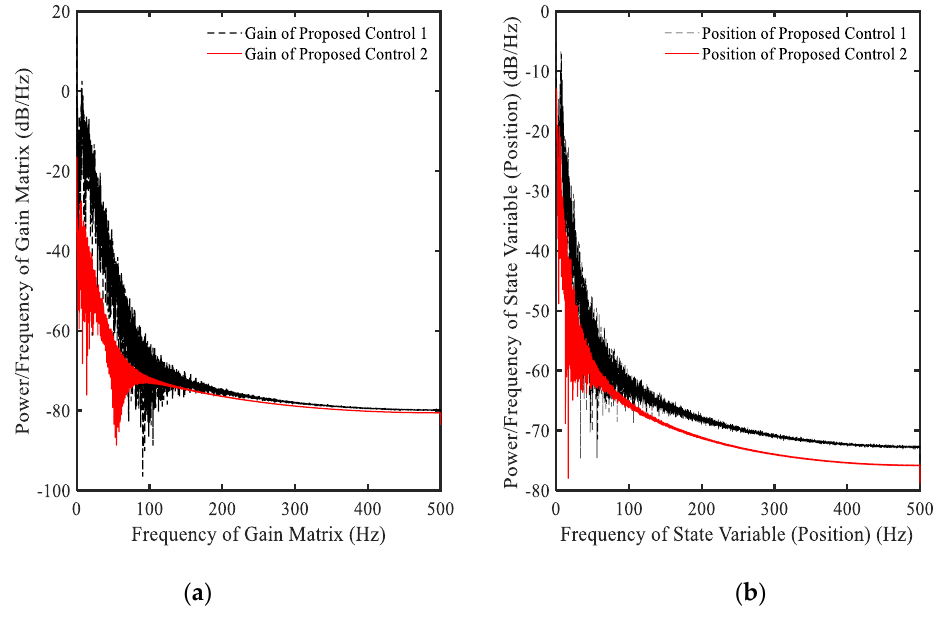
Figure 5. Power spectral density (PSD) of the proposed control 1 with Equation (12) and the proposed control 2 with Equation (7): ( a ) gain function Q ∆ L ( t ) , ( b ) state variable x e ( t )